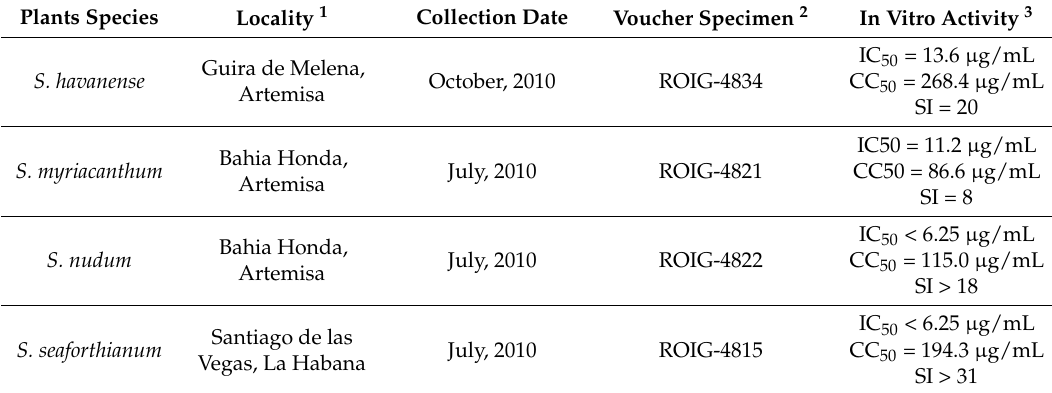
Table 1. General characteristics of plants from Solanum genus used in this